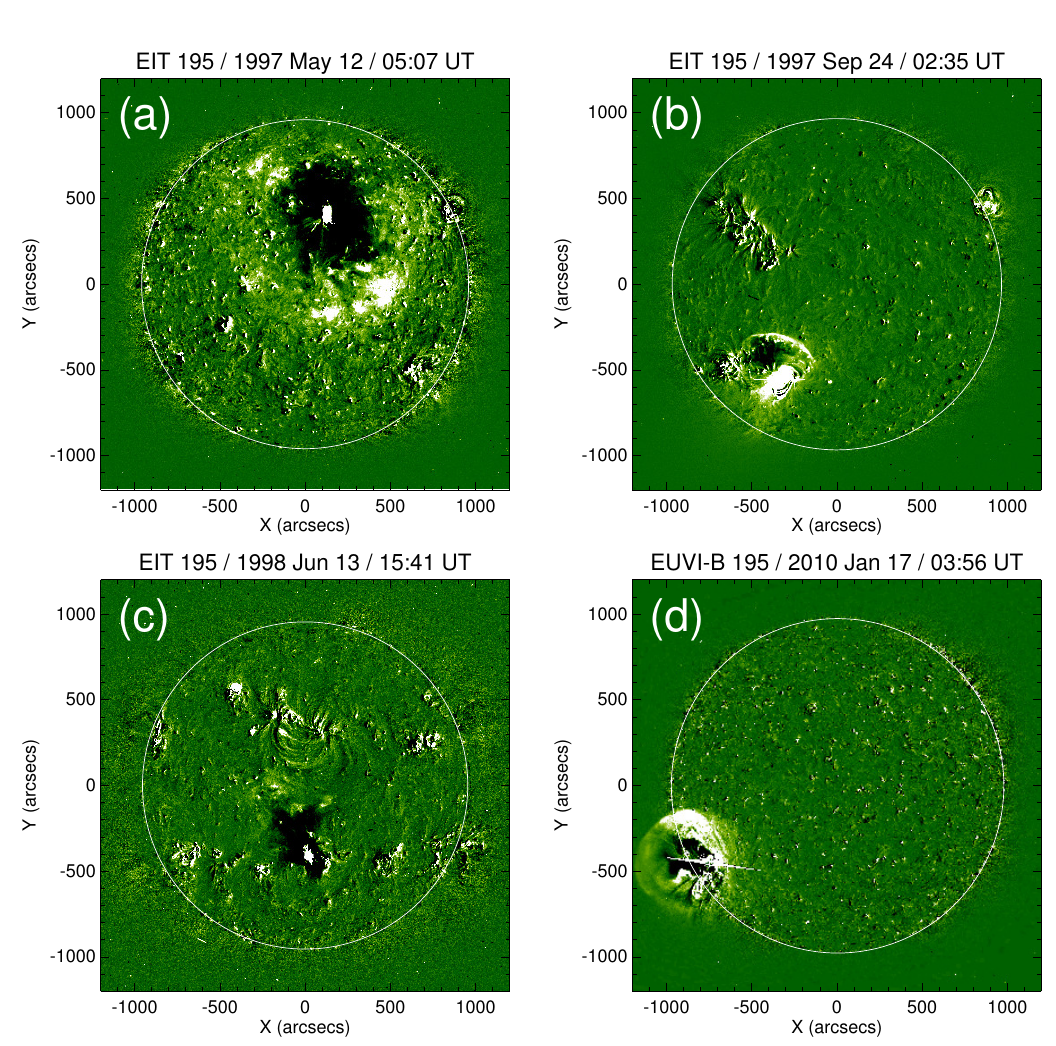
Figure 5: The diverse morphology of coronal EUV waves. (a): the diffuse globally propagating front of 1997 May 12. (b): the sharp S-wave of 1997 Sep 24. (c): the small-scale irregular wave of 1998 Jun 13. (d): the dome-shaped wave of 2010 Jan 17. All panels show difference images from which a pre-event image has been subtracted. In addition to the bright fronts, note the dark dimming regions close to the erupting active